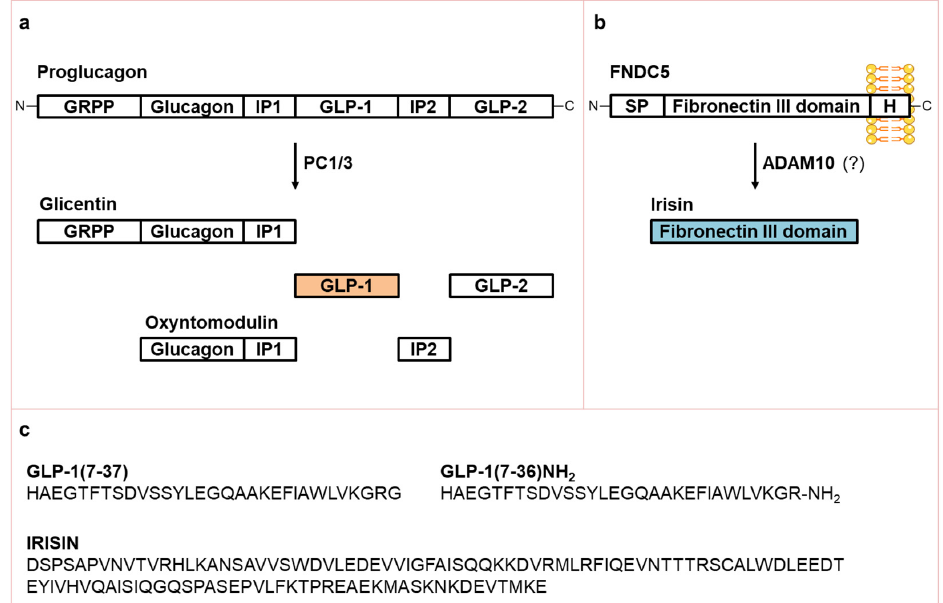
Figure 1. GLP-1 and irisin synthesis and aminoacid sequences. ( a ) Schematic representation of post-translational proglucagon processing by PC1/3; ( b ) Schematic representation of FNDC5 structure and cleavage to yield irisin; ( c ) aminoacid sequences of GLP-1(7–37), GLP-1(7–36)NH 2 , and irisin. ADAM10, A Disintegrin And Metalloproteinase domain-containing protein 10; C, C-terminal; FNDC5, fibronectin type III domain-containing protein 5; H, hydrophobic domain; GRPP, glicentin-related pancreatic polypeptide; GLP, glucagon-like peptide; IP, intervening peptide; N, N-terminal; PC1/3, prohormone convertase 1/3; SP, signal